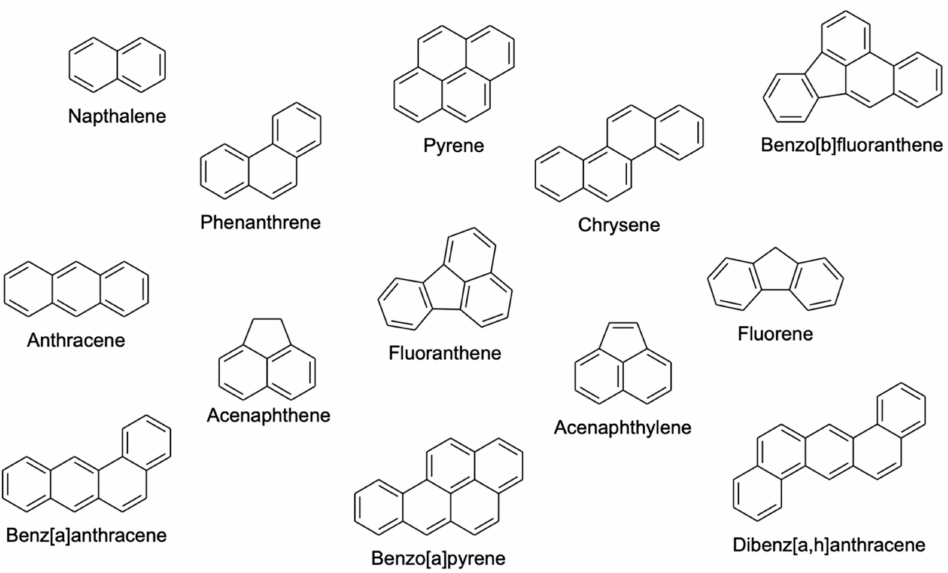
Figure 1. Chemical structures of common polycyclic aromatic hydrocarbons (PAHs)